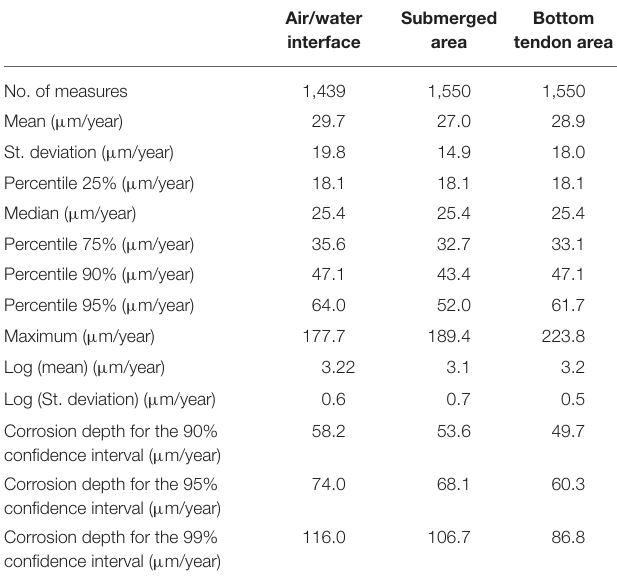
TABLE 3 | Corrosion depth experimental distribution values and main parameters of probability density functions fitted to a lognormal density function.